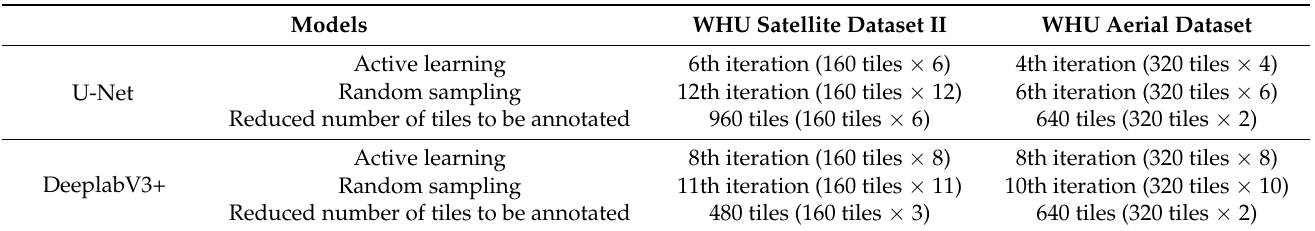
Table 3. Examples of the reduced number of image tiles to be annotated.